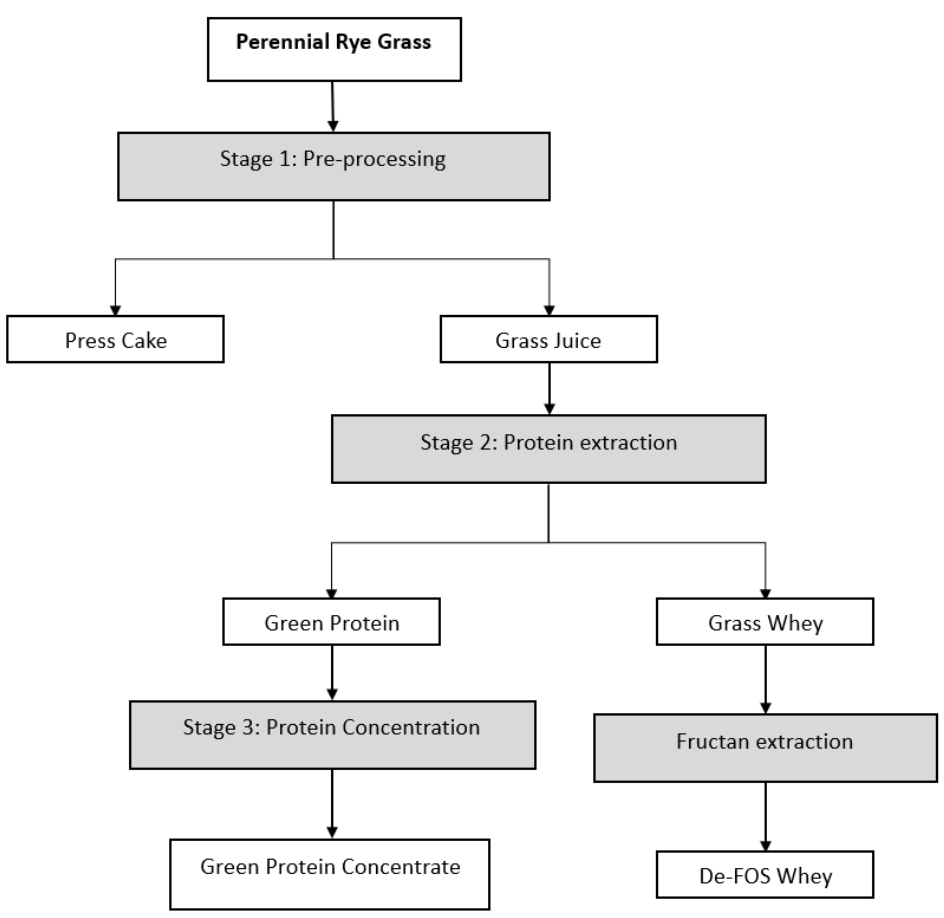
Figure 1. Schematic of green biorefinery process.